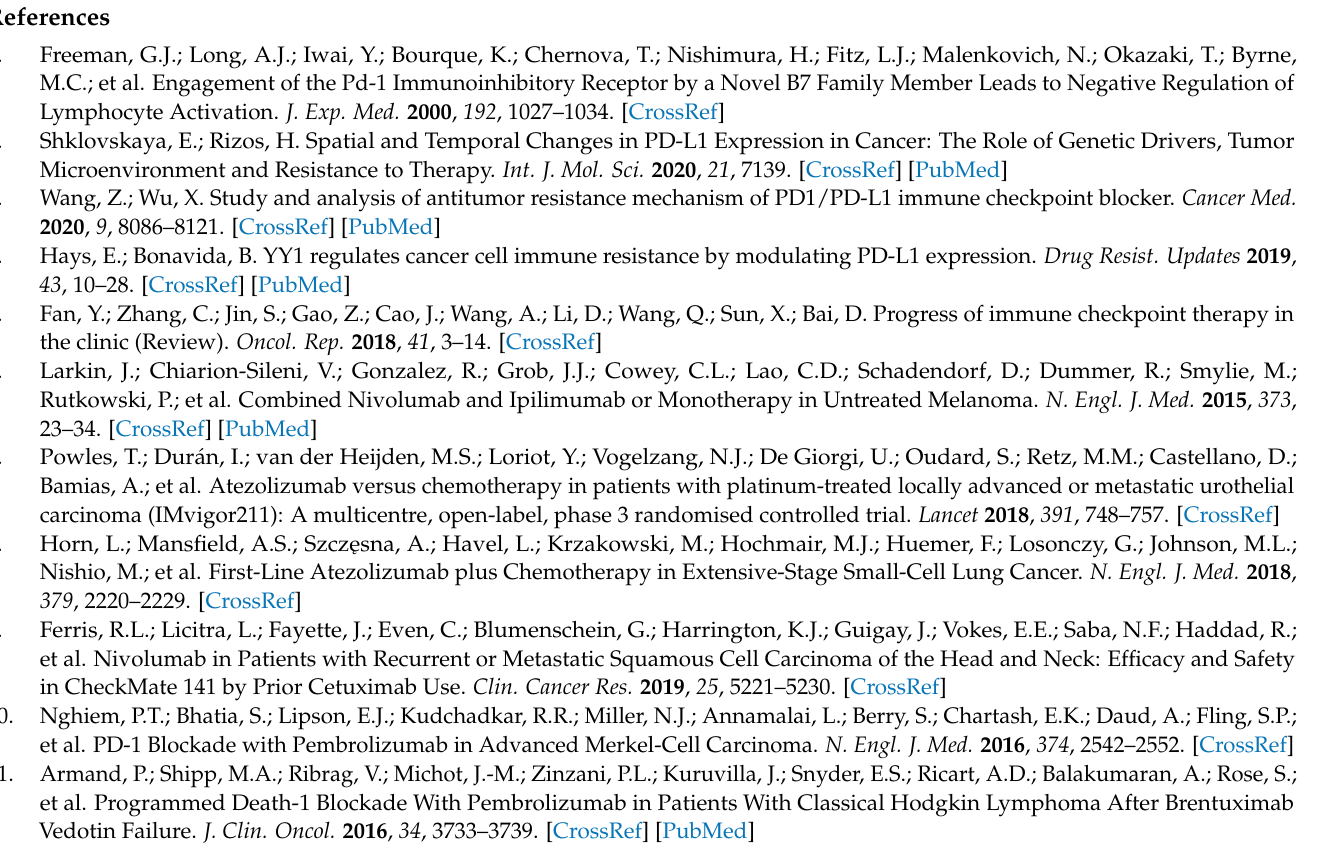
Figure S3. Cancer and stromal cells express PD-L1 in MC38 peritoneal tumors. Supplementary Figure S4. Persistence of vector in tumor and liver tissue in the PC